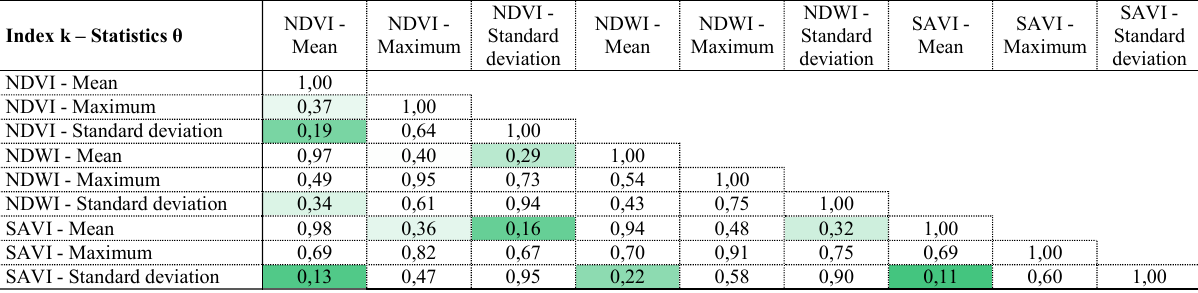
Table 3 . Pearson correlation coefficients between (𝑅𝐷 (cid:3038) ) (cid:3087) over DGT class (310 plots) and UDPI class (480). The Pearson correlation matrix between the remaining promising indicators was computed on the same dataset in Table 3. All coefficients are statistically significant at the 0.1% significance level (from Student table with degree of freedom around 800).